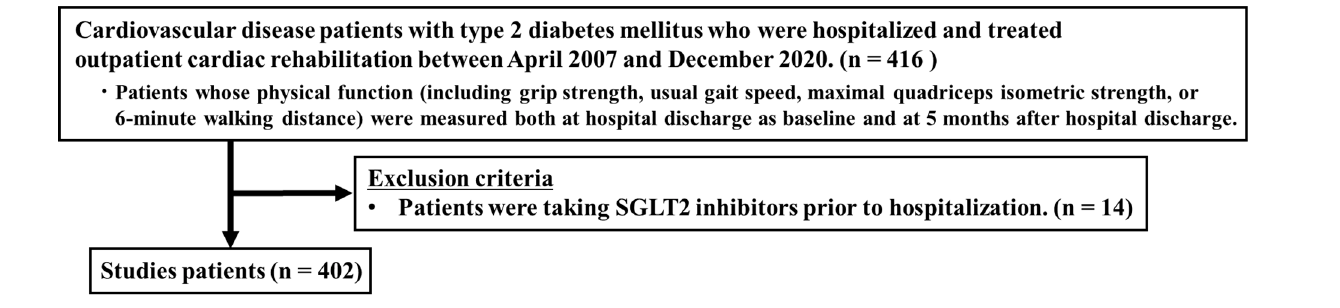
Figure 1. Flow chart in this study. SGLT2, Sodium-Glucose Cotransporter 2. Table 1. Baseline characteristics of patients using and not using SGLT2 inhibitors.